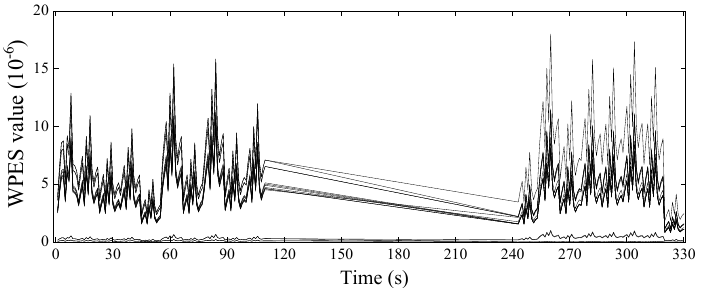
Figure 15. The temporal variation of WPES values containing a block of missing data.